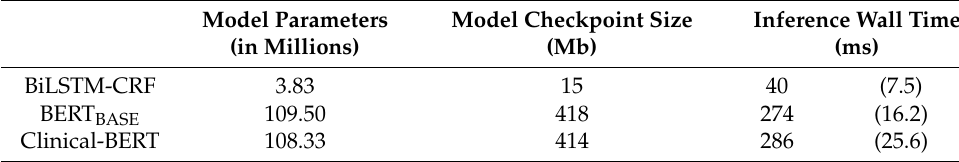
Table 4. Comparison of model complexity and inference speed. Inference wall time is reported using the mean and standard deviation of wall clock time over 100 iterations of predicting a sample sentence, without the overhead of loading libraries and the model